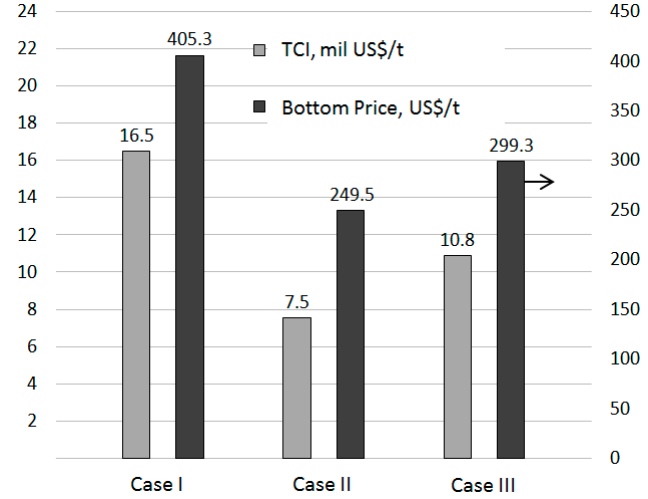
Figure 7. Comparison of the design cases using some results from the economic analyses.